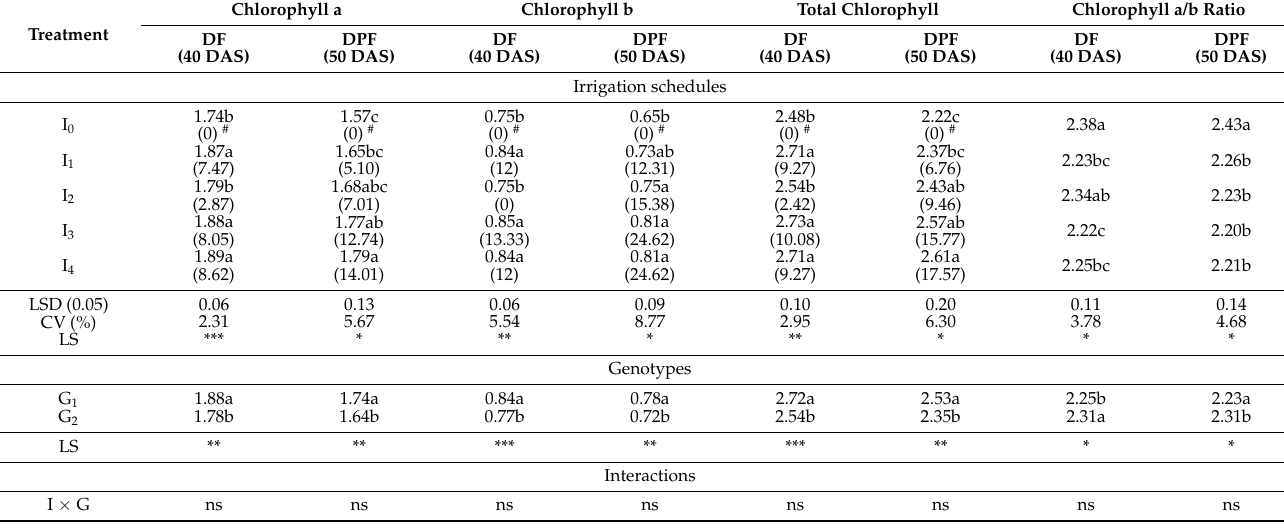
I × G ns ns ns ns ns ns ns ns Where, LS = level of significance; * significant at p = 0.05; ** significant at p = 0.01; *** significant at p = 0.001; I 0 = No irrigation; I 1 = Irrigation at 1st trifoliate leaf stage; I 2 = Irrigation at flowering stage; I 3 = Irrigation at 1st trifoliate leaf stage + flowering stage; I 4 = Irrigation at 1st trifoliate leaf stage + flowering stage + pod-filing stage; G 1 = Genotype BMX-08010-2; G 2 = Genotype BARI Mung-1; DF = Days to flowering; DPF = Days to pod filing; # % increase over control (No irrigation), ns = not significant; Data followed by the same letter are not differed significantly by LSD test at p <